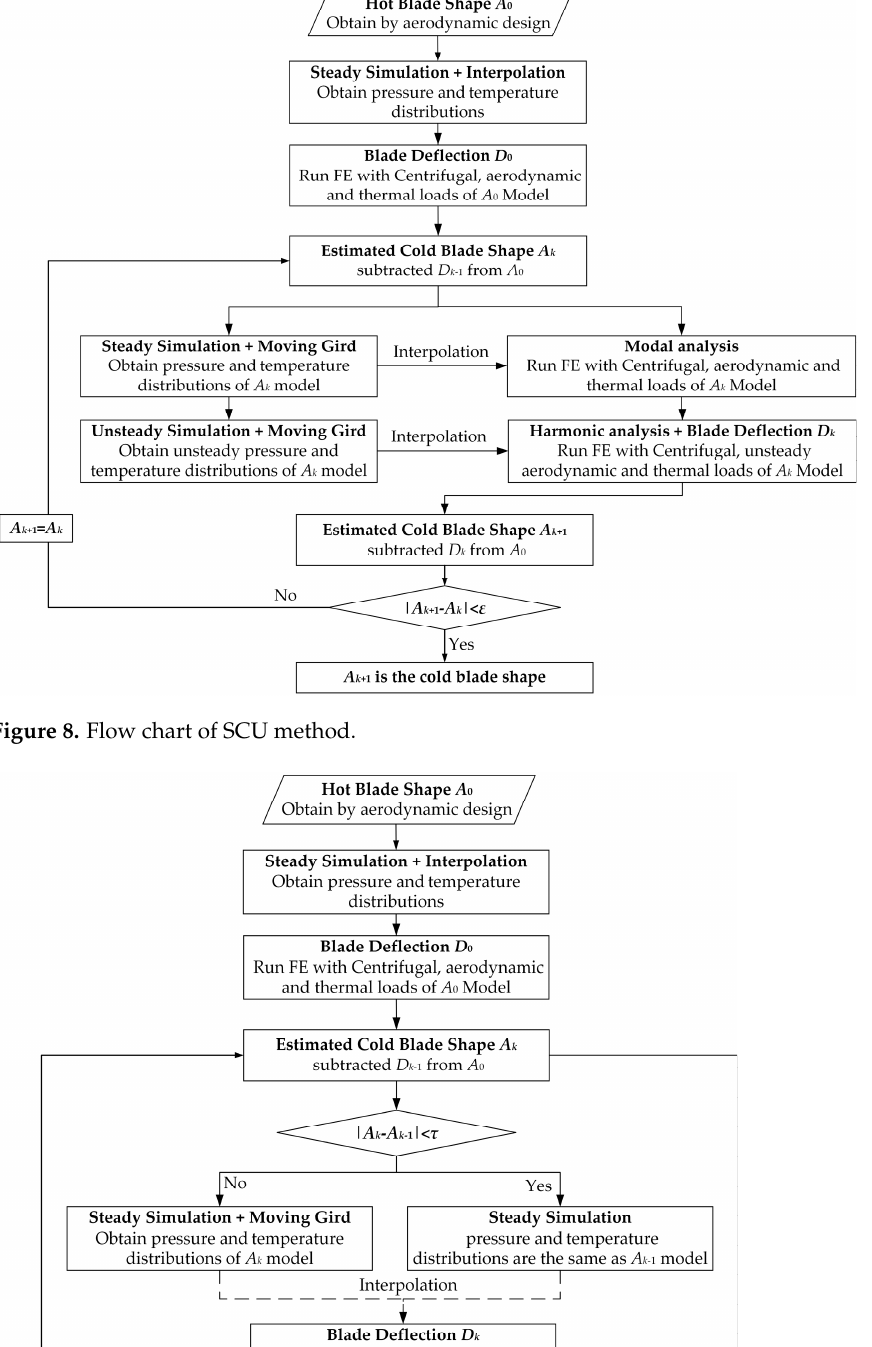
7 of 16 Figure 7. Flow chart of WCS method. 2.3.3. Strong Coupling Method with Unsteady Simulation (SCU)